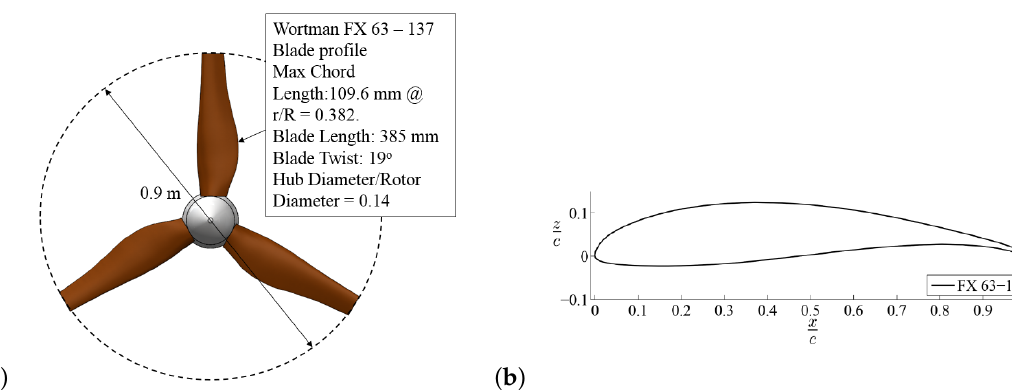
Figure 2. Rotor schematic for the 0.9 m HATT used for the testing ( a ) and Wortman FX 63-137 profile used to create the turbine blade geometry ( b